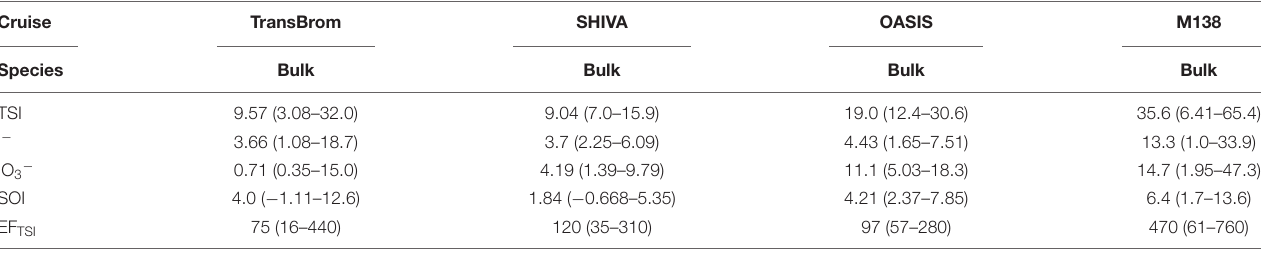
TABLE 4 | Median and range of soluble iodine species concentrations (pmol m − 3 ) and enrichment factor (EF) of TSI in bulk aerosols for SHIVA and total (fine + coarse) for TransBrom, OASIS, and M138.